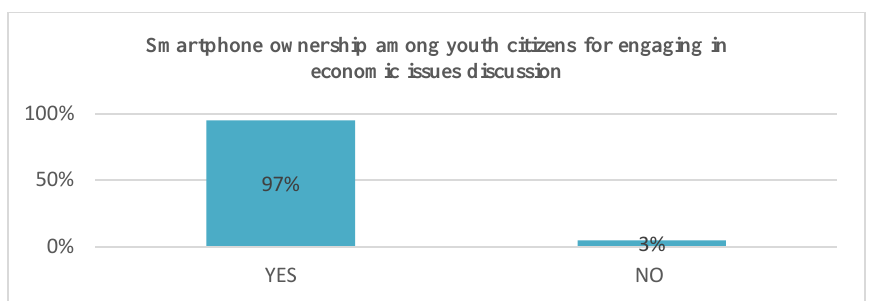
Table 1 : Showing Percentages of Smartphone Ownership Among Youth